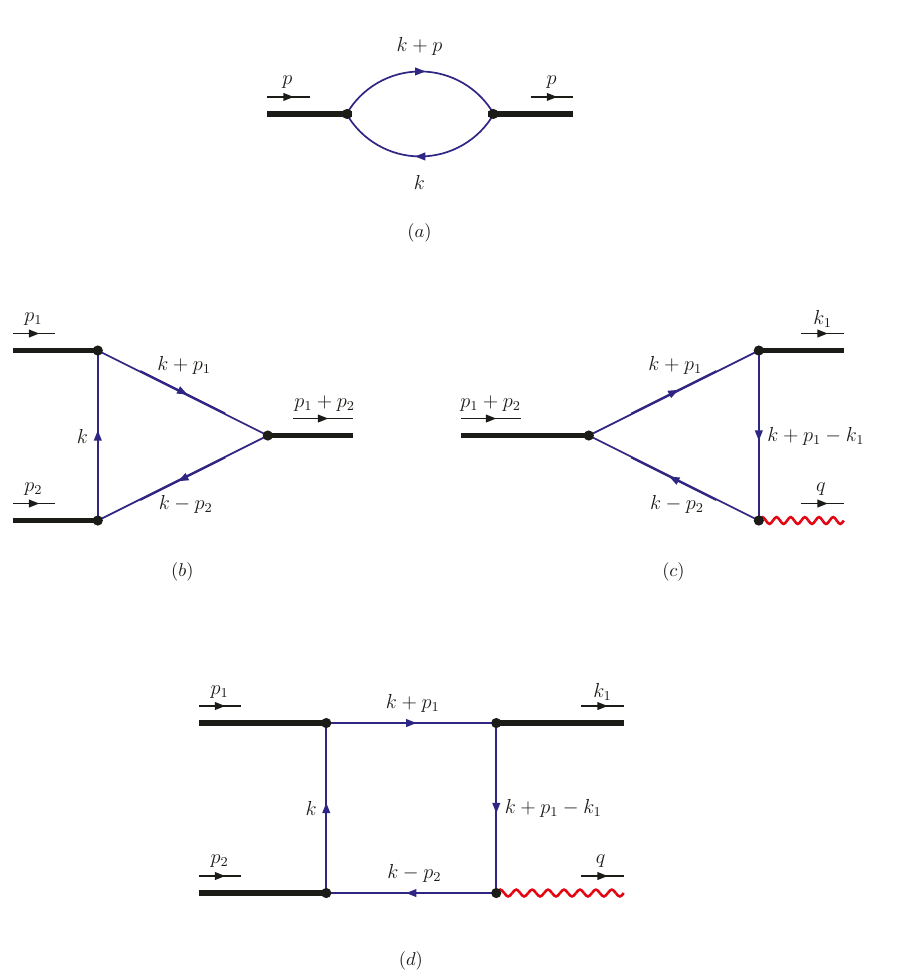
Figure 1 . Loop diagrams: bubble (a), triangle (b) and (c), and box